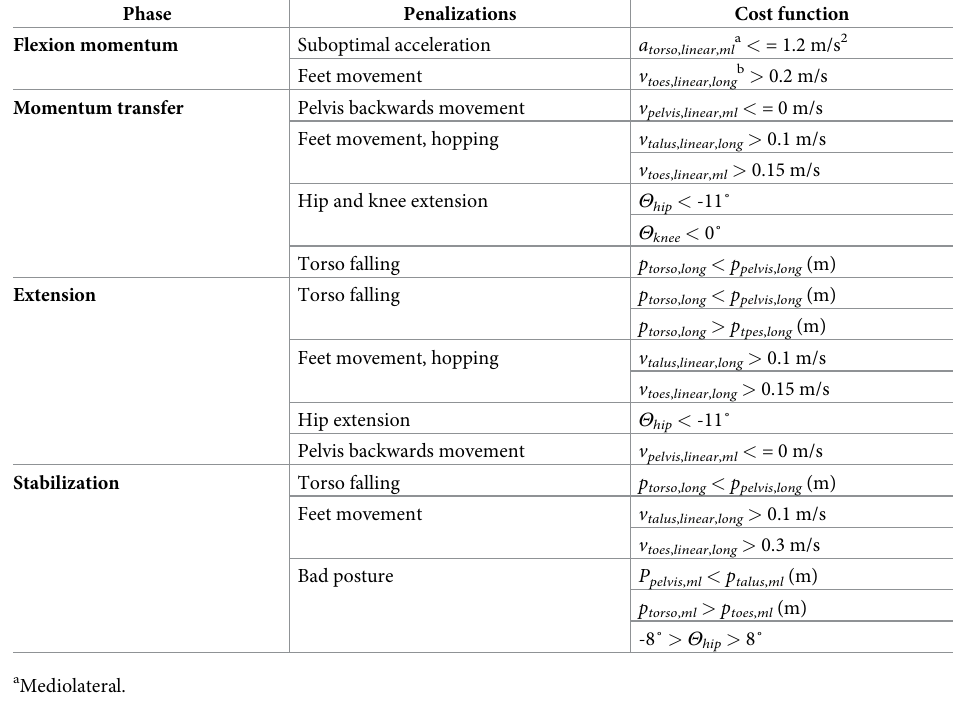
Table 3. Phase-dependent penalizations in the cost function for the 4-phases controller optimization.